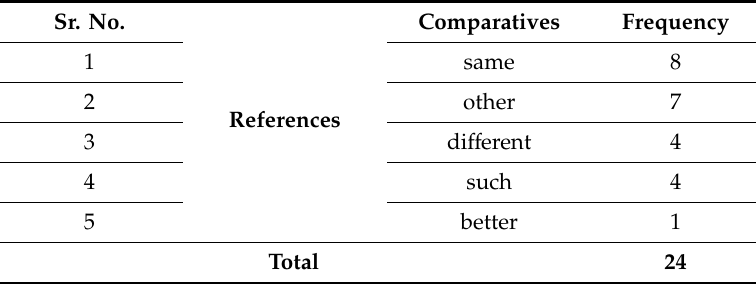
Table 21. Comparative